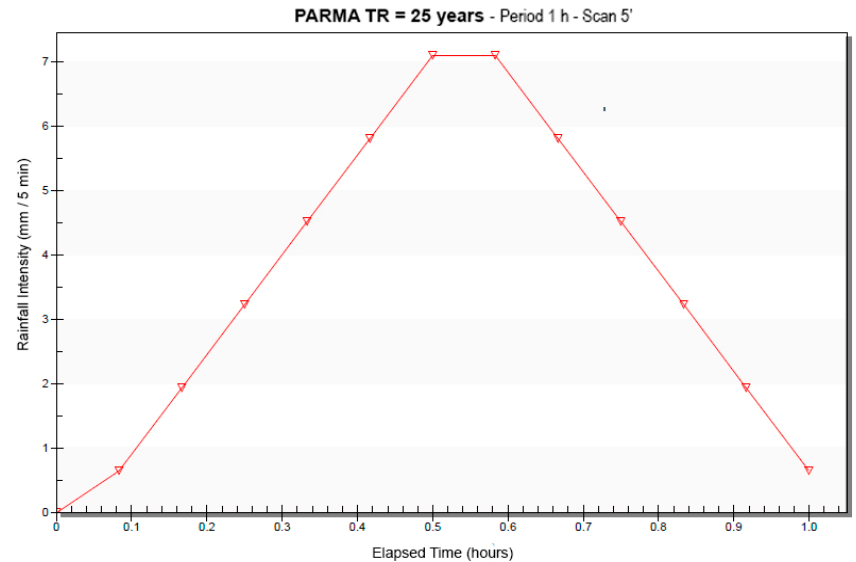
Figure 3. Design storm for a return period of 25 years and an event duration of 1 h.